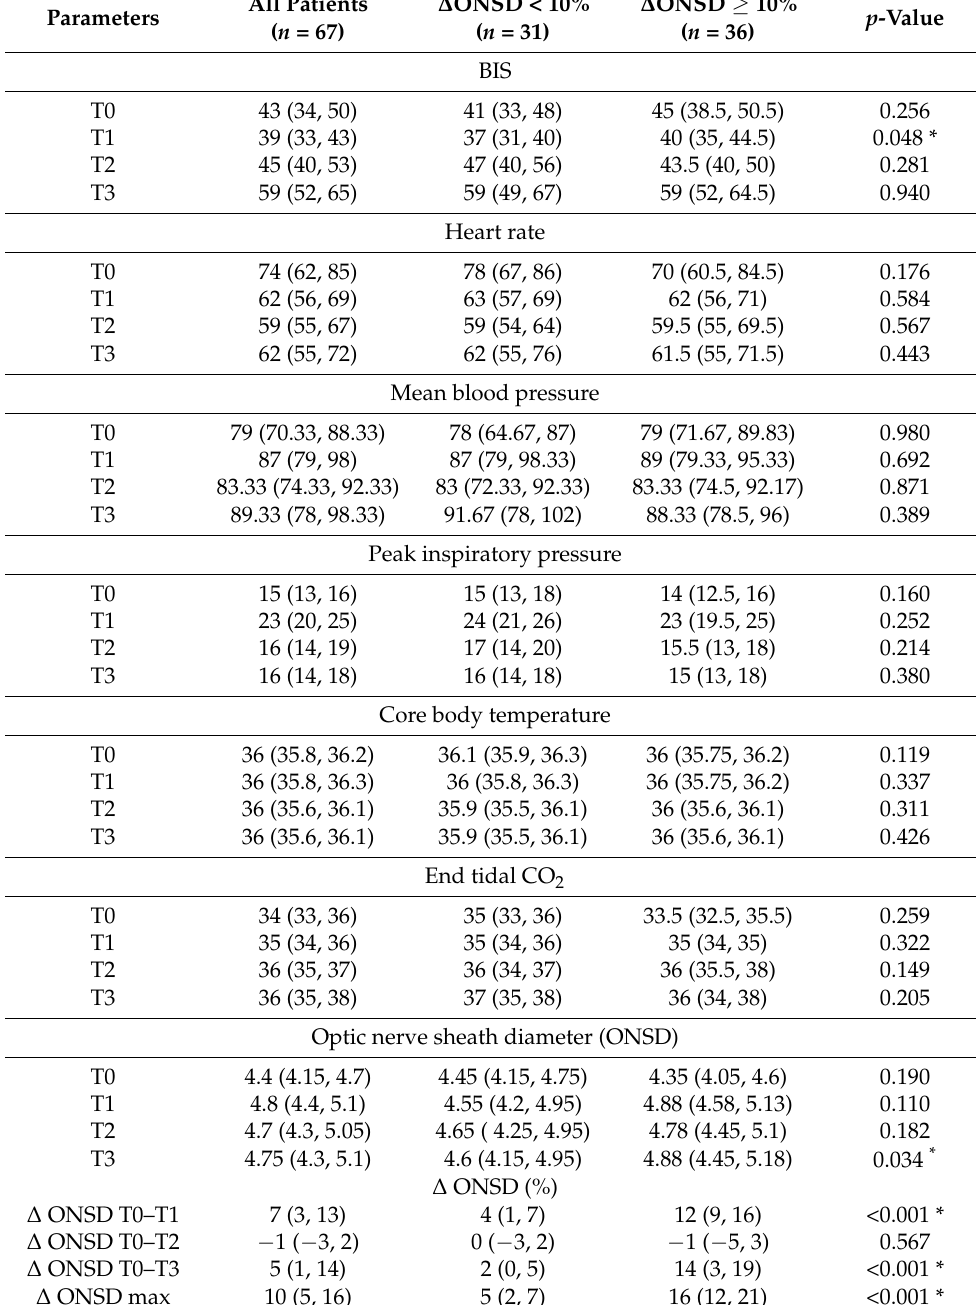
Table 2. Intraoperative